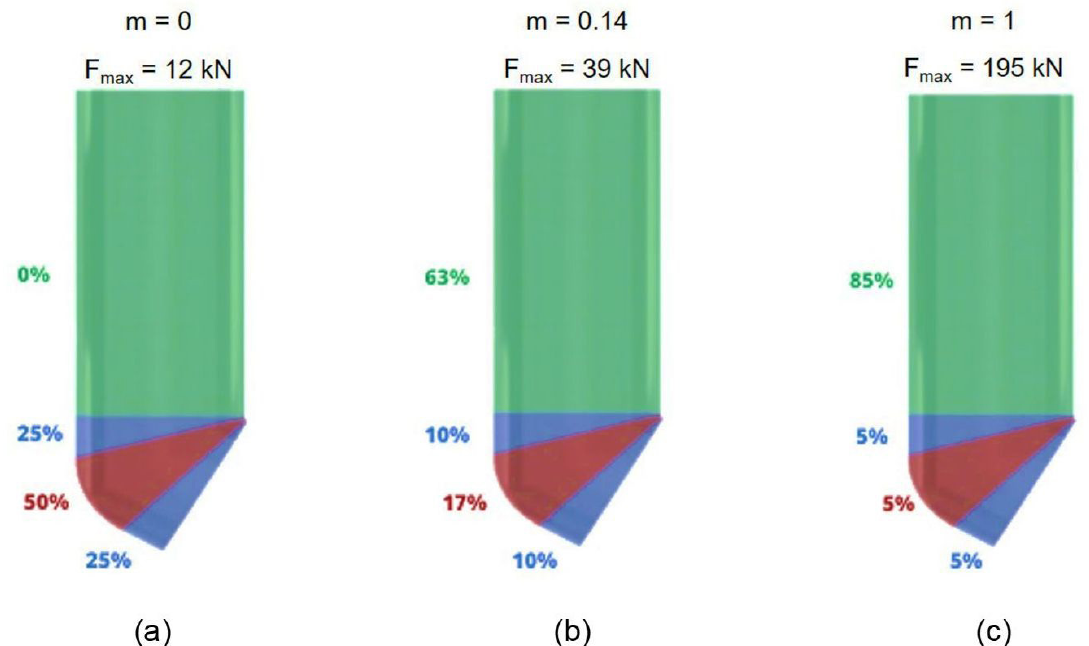
Figure 8. Influence of the friction factor on the power dissipation in each region of the ECAP die channel for a billet with a length of 30 mm: (a) m = 0; (b) m = 0,14; (c) m =